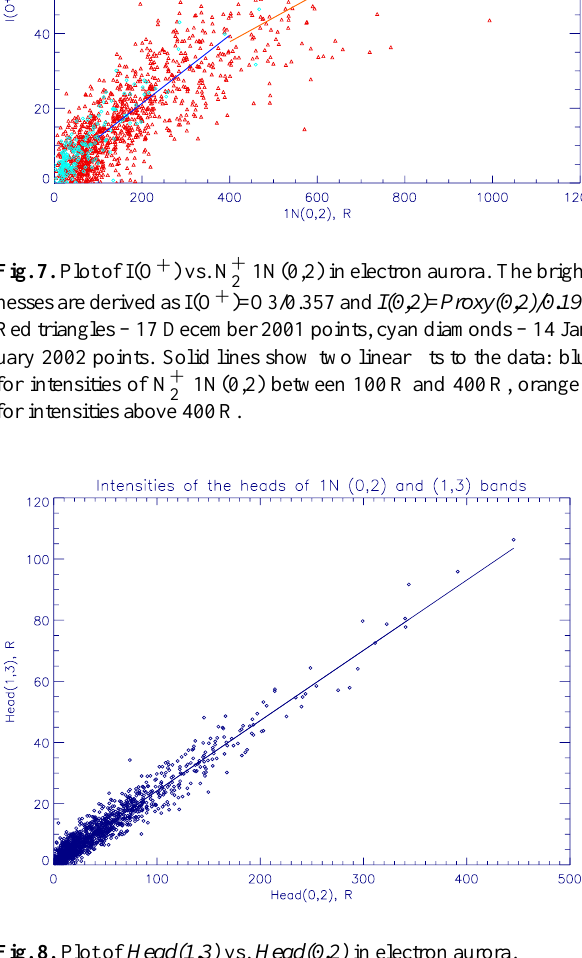
I(1,3)/I(0,2) should be 0.222. A scatter plot of the Head(1,3)